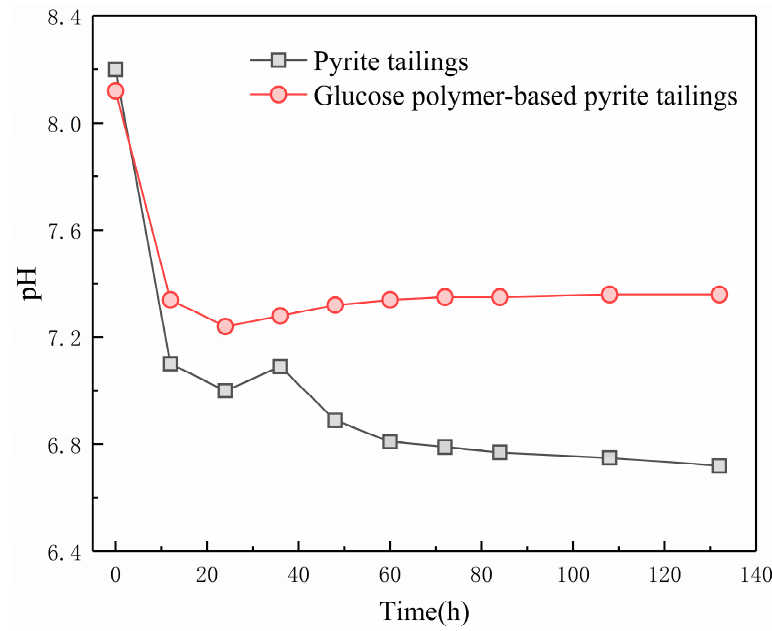
Figure 3. Change diagram of pH in denitrification system before and after pyrite tailings coating.